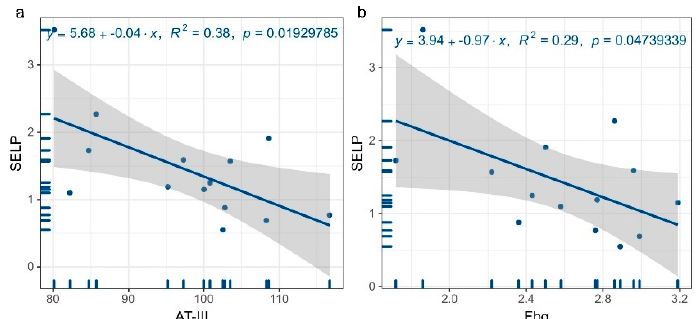
Figure 6. Regression plots of SELP and coagulation factor levels. ( a ) Regression plot of SELP and AT-III levels, ( b ) regression plot of SELP and Fbg levels.